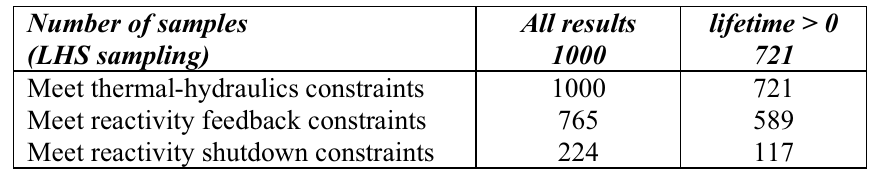
Table 2. Number of cores sampled meeting design